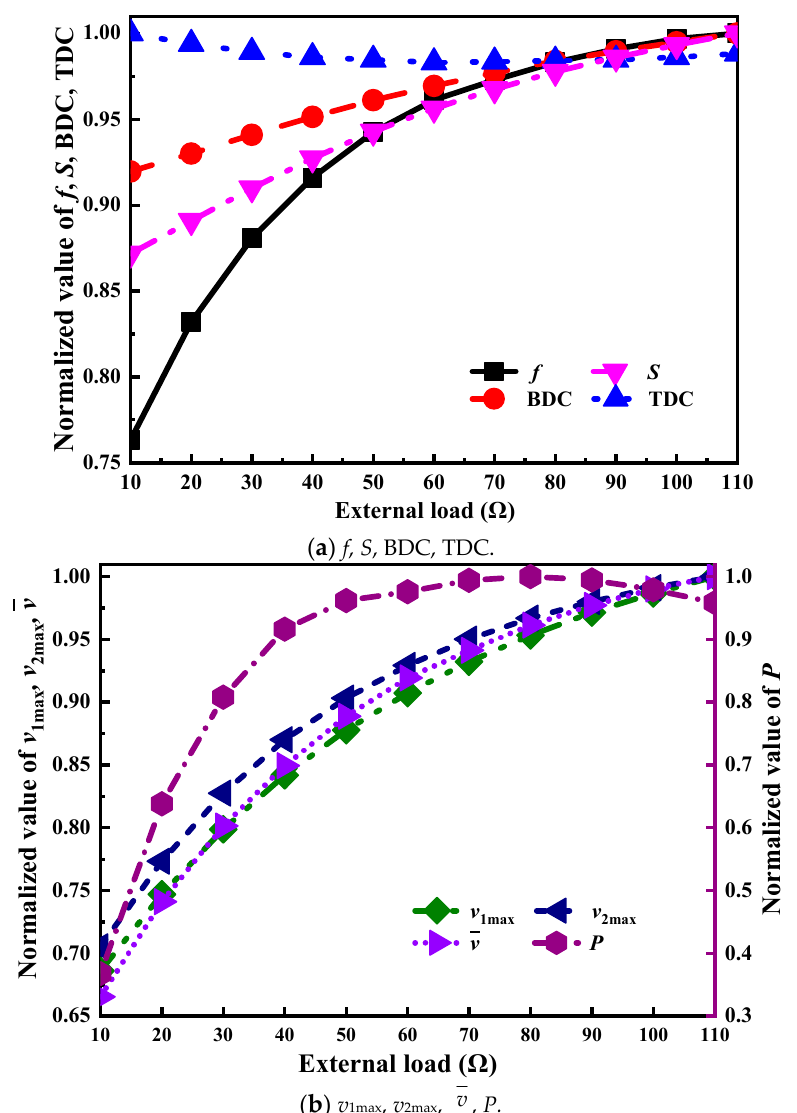
Figure 15. Variation of performance parameters with external load.